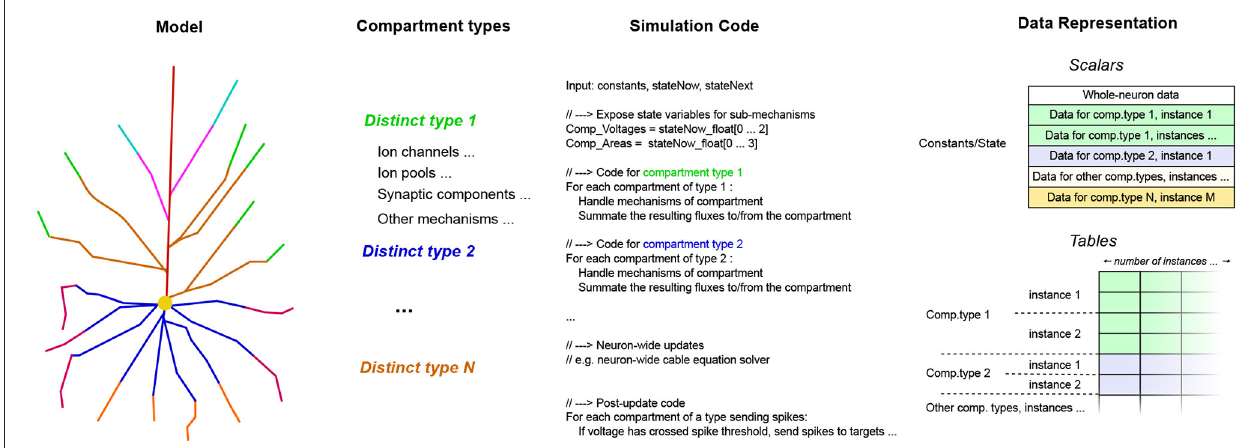
FIGURE 5 | The stages of the per-compartment signature de-duplication process, from the abstract model to the concrete implementation. On the schematic of the detailed neuron model, distinct compartment types are shown in different colors. The components sharing the same type are then grouped together, in terms of simulation code and data representation. The specific mechanisms comprising the compartments and the data cells they contain are not shown here, for